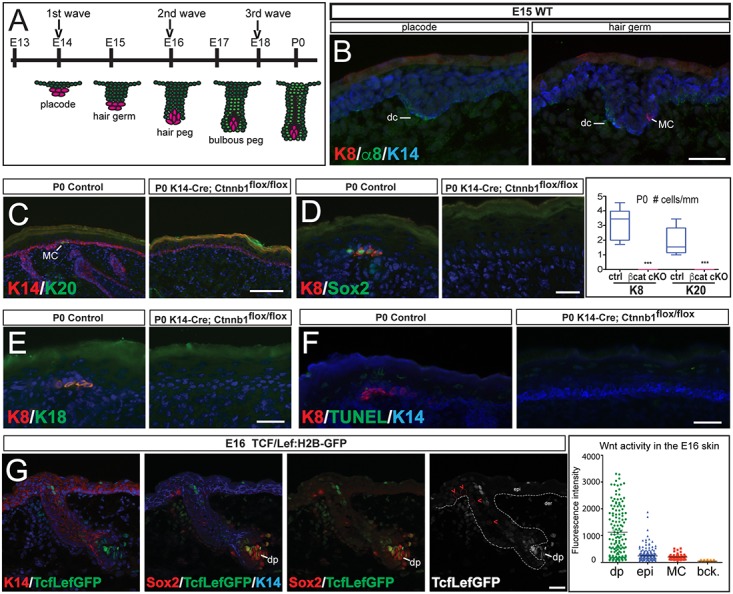
Loss of Wnt/β-catenin signaling abrogates hair follicle development and Merkel specification.(A) Schematic diagram of hair follicle development, with the different stages and the timing of each wave of hair follicle development represented. The epidermal cells are labeled in green and the mesenchymal cells that form the dermal condensate in the hair placode, germ, and peg stages, and the dermal papilla in the bulbous peg stage and the mature hair follicle are labeled in pink. (B) At E15, the first wave hair follicles are in the placode and hair germ stages. Early immature Krt8(+) (K8) Merkel cells (MC) are found around the WT first wave developing hair follicles at the hair germ stage (0% of placodes and 57.90% of hair germs contained Merkel cells; 100 hair follicles analyzed). Krt14 (K14) and integrin α8 (α8), which labels the dermal condensate (dc), are used to identify the developing hair follicles. (C-E) IF stainings for Merkel cell (MC) markers Krt20 (K20) (C), Krt8 (K8) (D,E), Sox2 (D), and Krt18 (K18) (E) show a complete absence of Merkel cells in P0 β-catenin epidermis-conditional knockout (β-cat cKO) (K14-Cre;Ctnnb1flox/flox) mice compared to control (ctrl). Quantification of Krt8+ and Krt20+ Merkel cells in control and β-cat cKO P0 skin (right panel of D) (both p<0.0001). (F) Terminal deoxynucleotidyl transferase dUTP nick end labeling (TUNEL) staining, which labels fragmented nuclear DNA, shows no increase in apoptosis in the Krt14(+) basal layer of P0 β-cat cKO mice. Note that cells undergoing cornification in the suprabasal layers stain positive for TUNEL as previously reported [33]. (G) The reporter of Wnt signaling activity, Tcf/Lef:H2B-GFP (TcfLefGFP), is used to measure Wnt signaling activity in the skin by measuring fluorescence intensity (right panel) in different cells of the skin. At E16, the Merkel cells do not have high levels of Wnt signaling. The dermal papilla (dp) cells are identified by Sox2 expression and are enveloped by the hair follicle; the epidermal cells are Krt14(+) (K14); the Merkel cells are Sox2(+) and are localized adjacent to the hair follicle. White dashed line separates the epidermis (epi) and dermis (der); red dashed line and arrowheads mark the Merkel cells. Non-nuclear background (bck) was measured. Scale bars: (C): 100μm; (B,D-G): 25 μm.